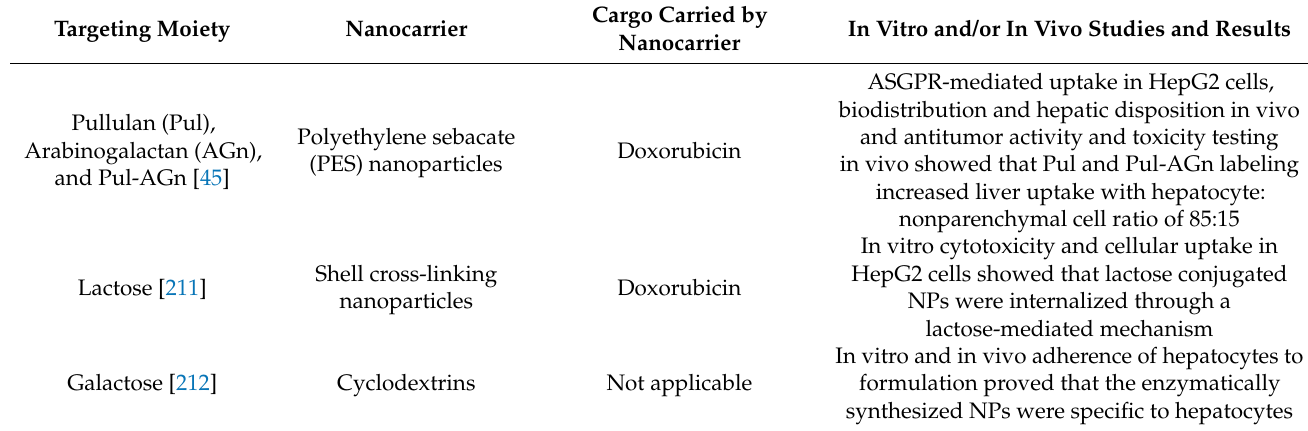
Table 1. Different nanoformulations showing ASGPR targeting in